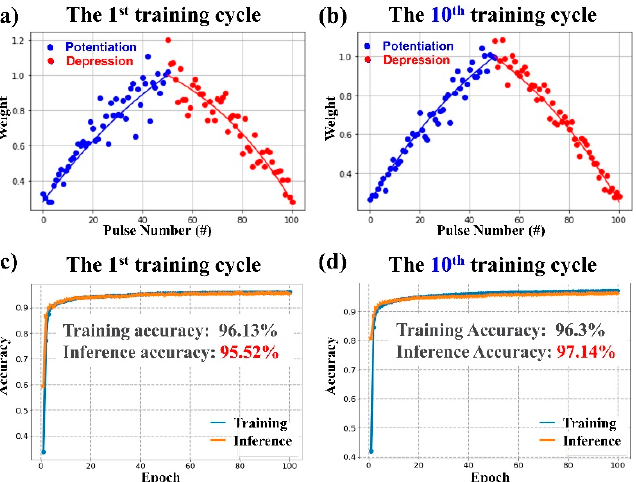
Figure 11. The simulated weight in ( a ) the 1st training cycle and ( b ) the 10th training cycle. The training and inference accuracy in ( c ) the 1st training cycle and ( d ) the 10th training cycle.